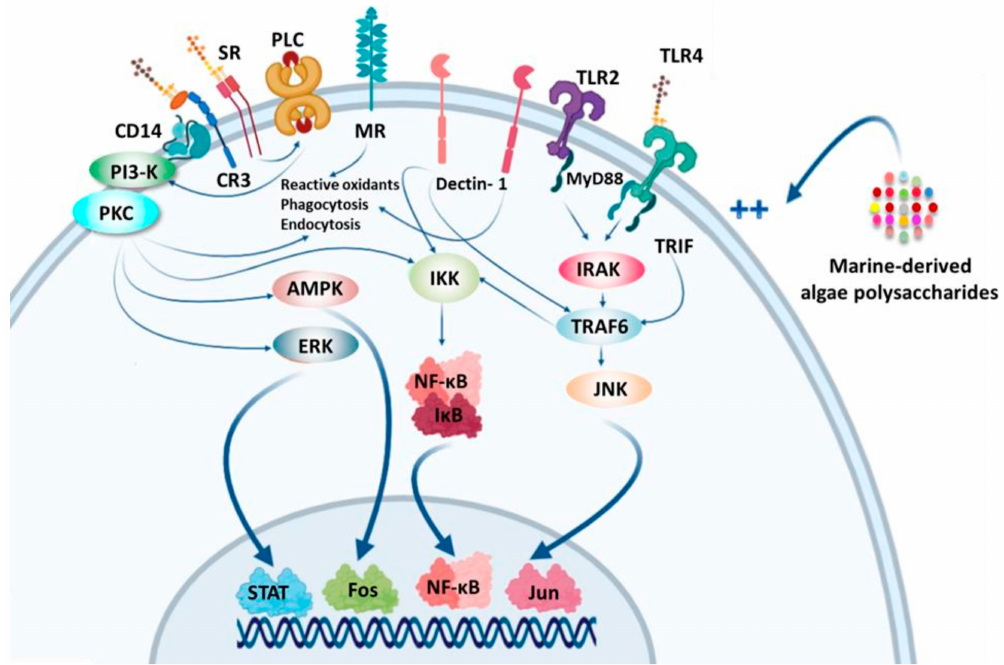
Figure 15. Signaling pathways involved in macrophage activation by algal-sulfated